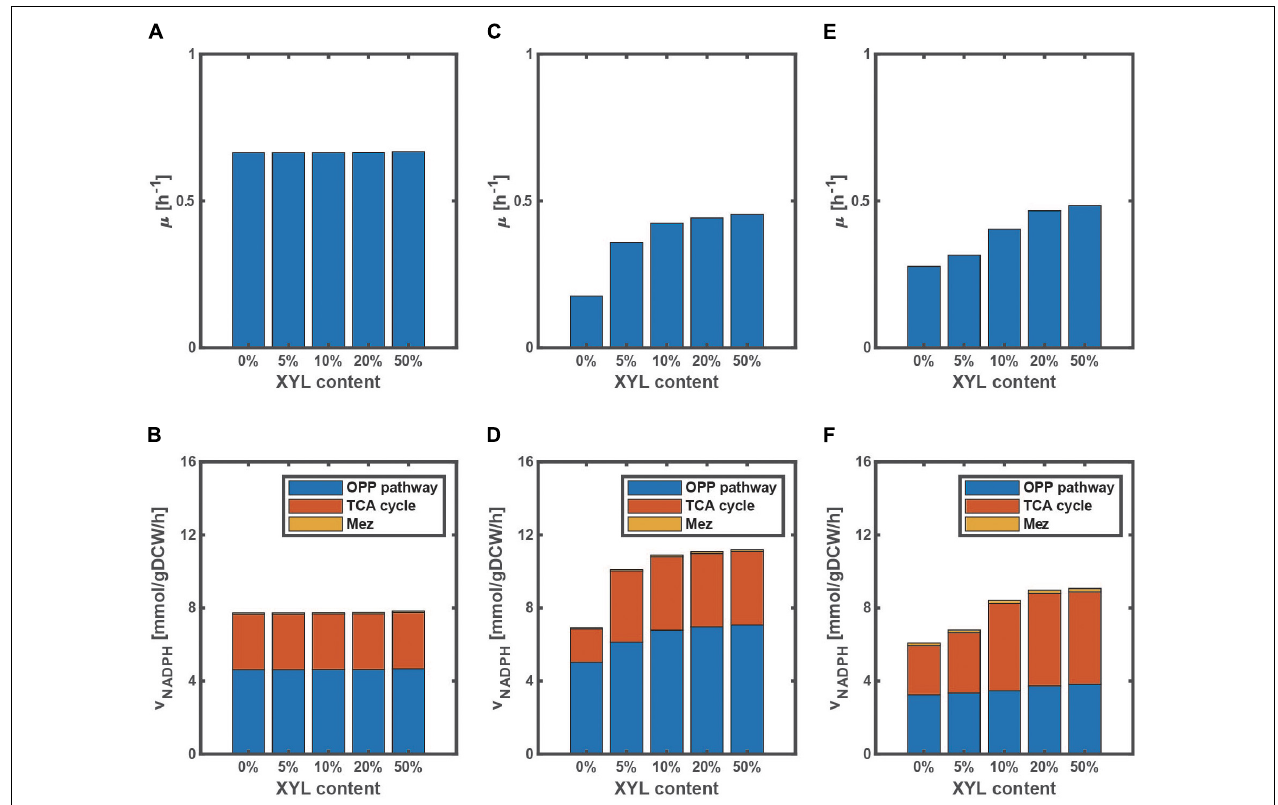
FIGURE 3 | Effect of the change in xylose content on the specific growth rate and the specific NADPH production rate during the exponential phase in wild type (A,B) , pgi mutant (C,D) , and ptsG mutant (E,F) grown on a mixture of glucose and xylose. The xylose content [%] is defined as the ratio of xylose contained in a mixture. The total substrate concentration is 10